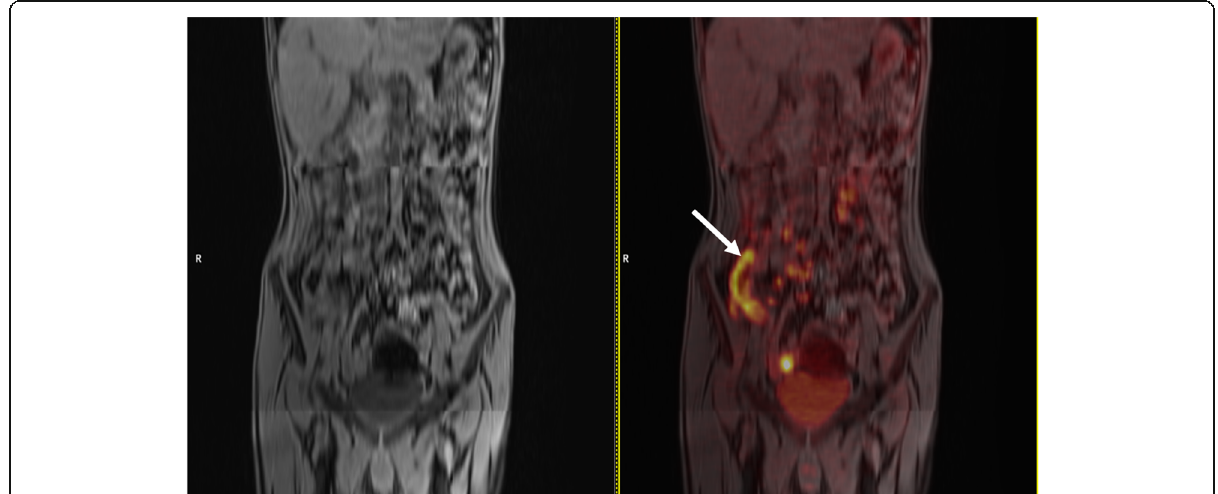
Fig. 3 Hybrid PET/MRI imaging of the abdomen. Eccentric thickening of the ileoceacal junction is noted with FDG tracer uptake (white arrow)